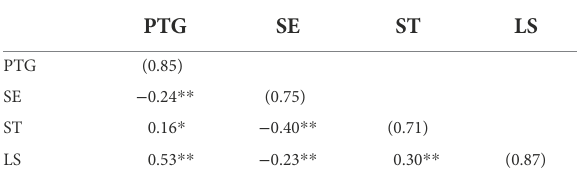
TABLE 2 Inter-construct correlation